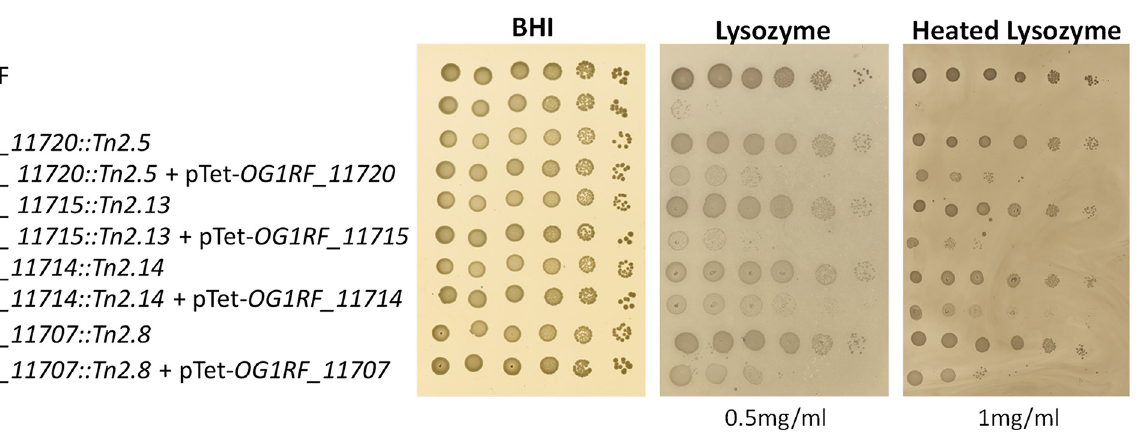
Fig 2. Growth defect of E . faecalis Tn mutants in the presence of antimicrobials targeting the cell envelope. Cell suspensions were prepared as described in S1 Fig and 1.5 μ l of serial dilutions were spotted on BHI-agar plates containing 10 ng ml -1 anhydrotetracycline and various concentrations of lysozyme. Concentrations showing a clear difference in susceptibility are